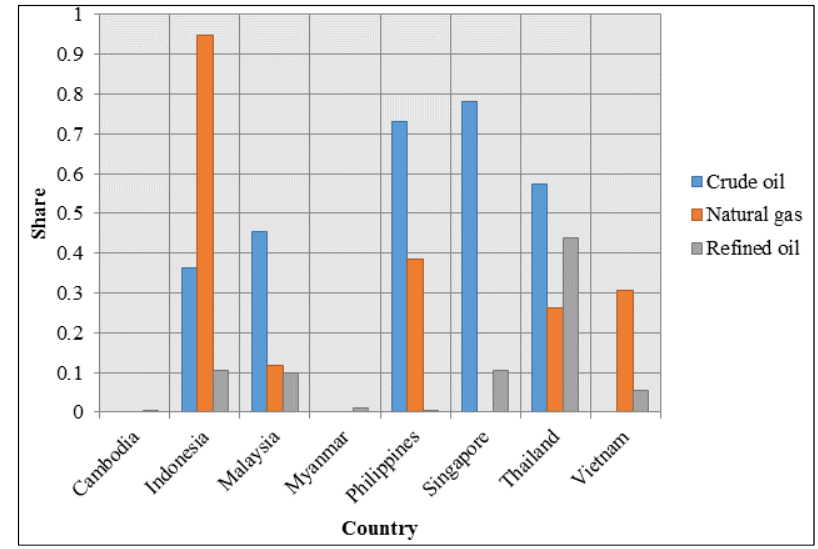
Figure 43. Reliance on imports from the Middle